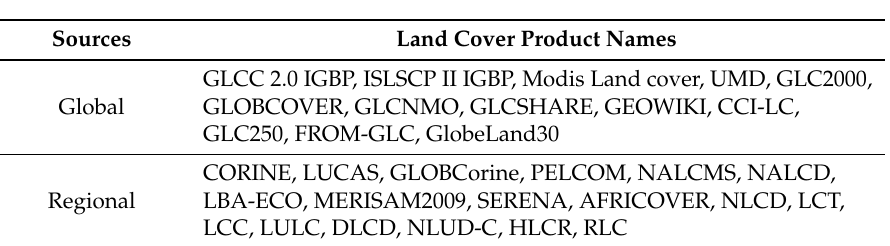
Table 6. Land cover product